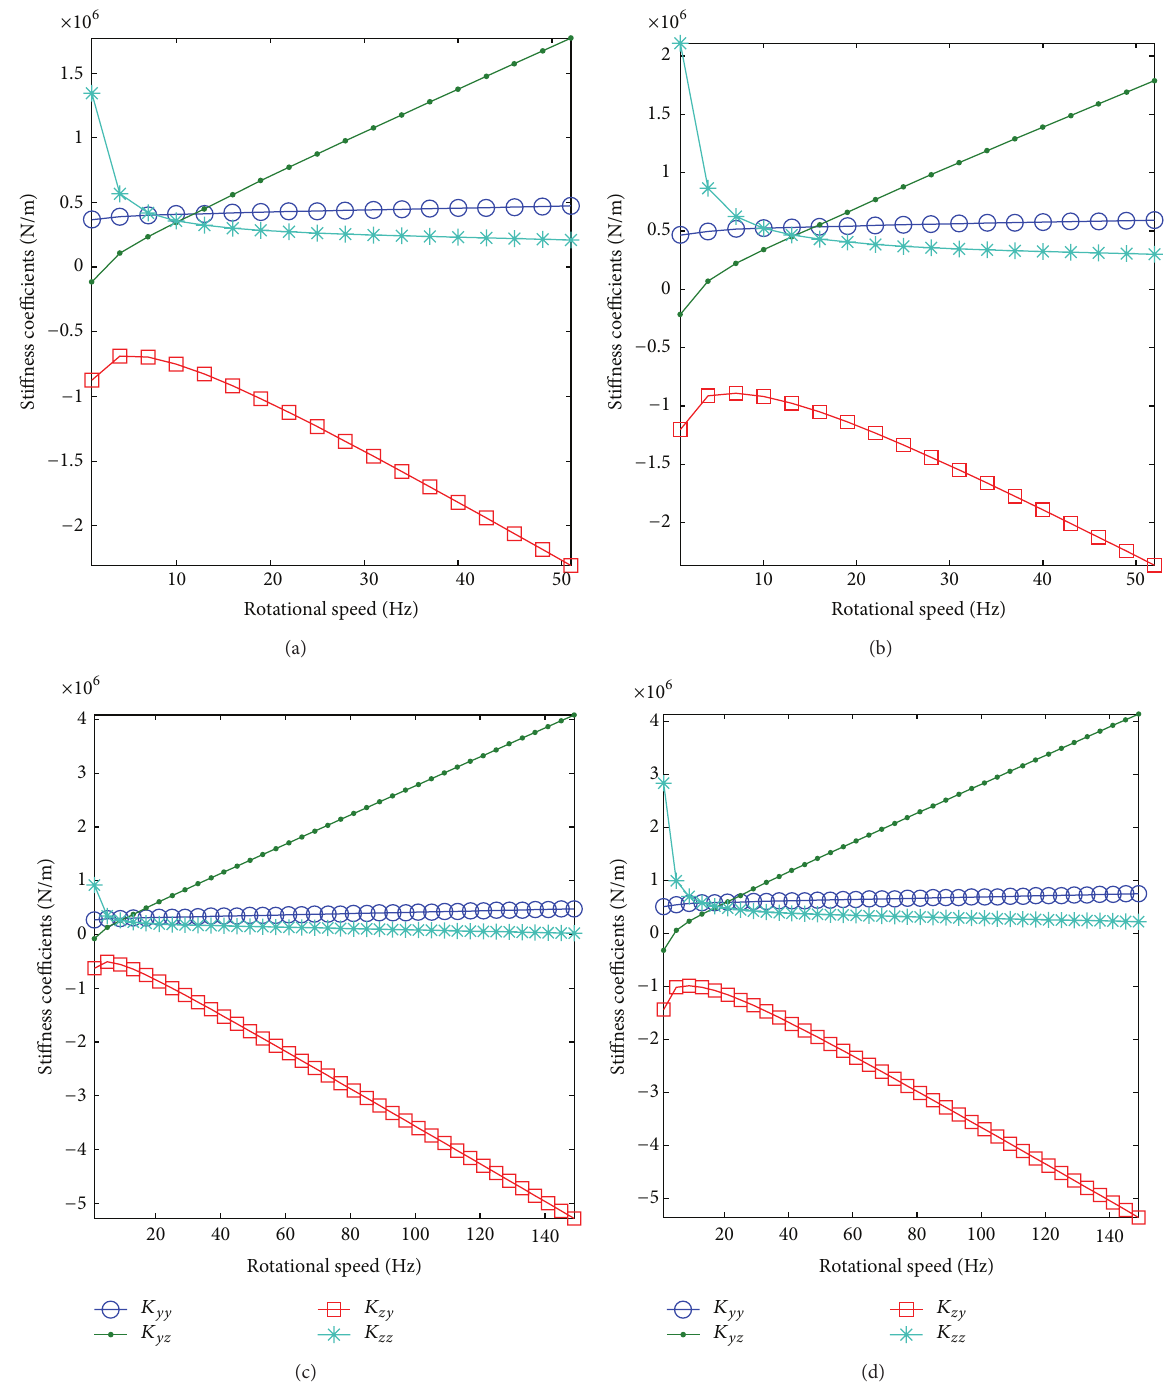
Figure 3: Equivalent coefficients of stiffness for the journal bearings: (a) bearing 1 in configuration A; (b) bearing 2 in configuration A; (c) bearing 1 in configuration B; (d) bearing 2 in configuration